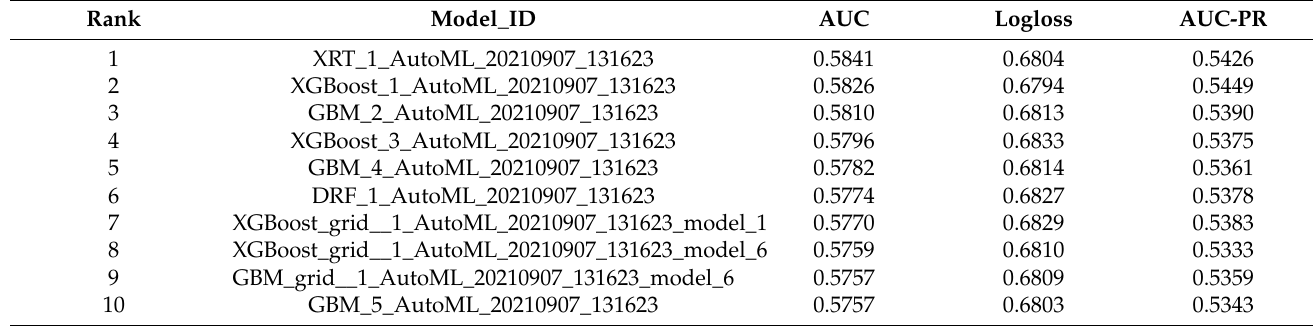
Table 6. Performance